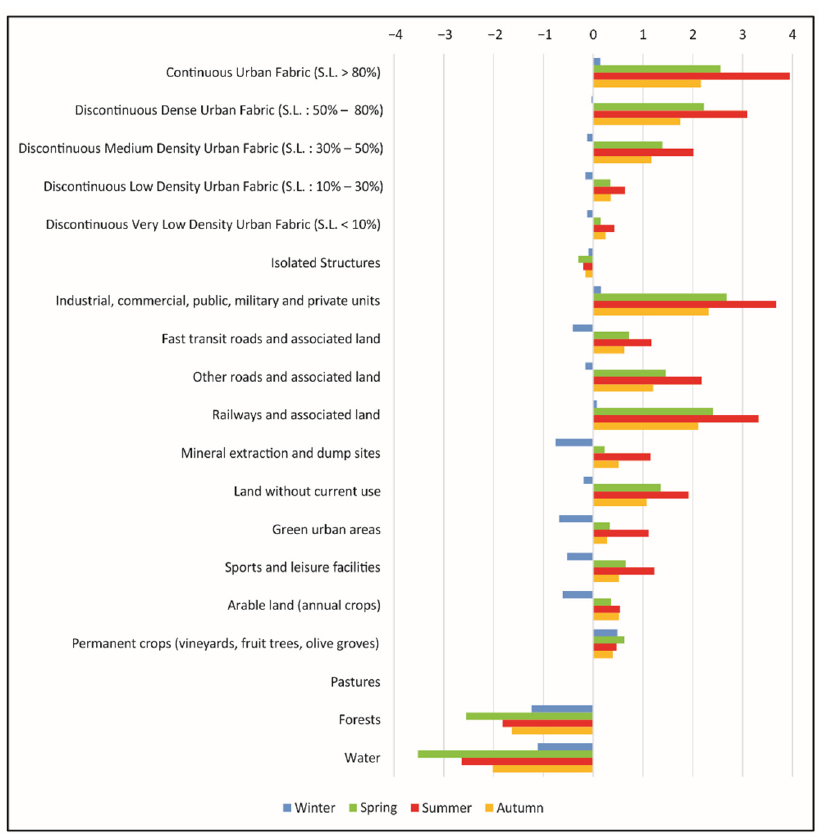
Figure 3. SUHI intensity by season and UA